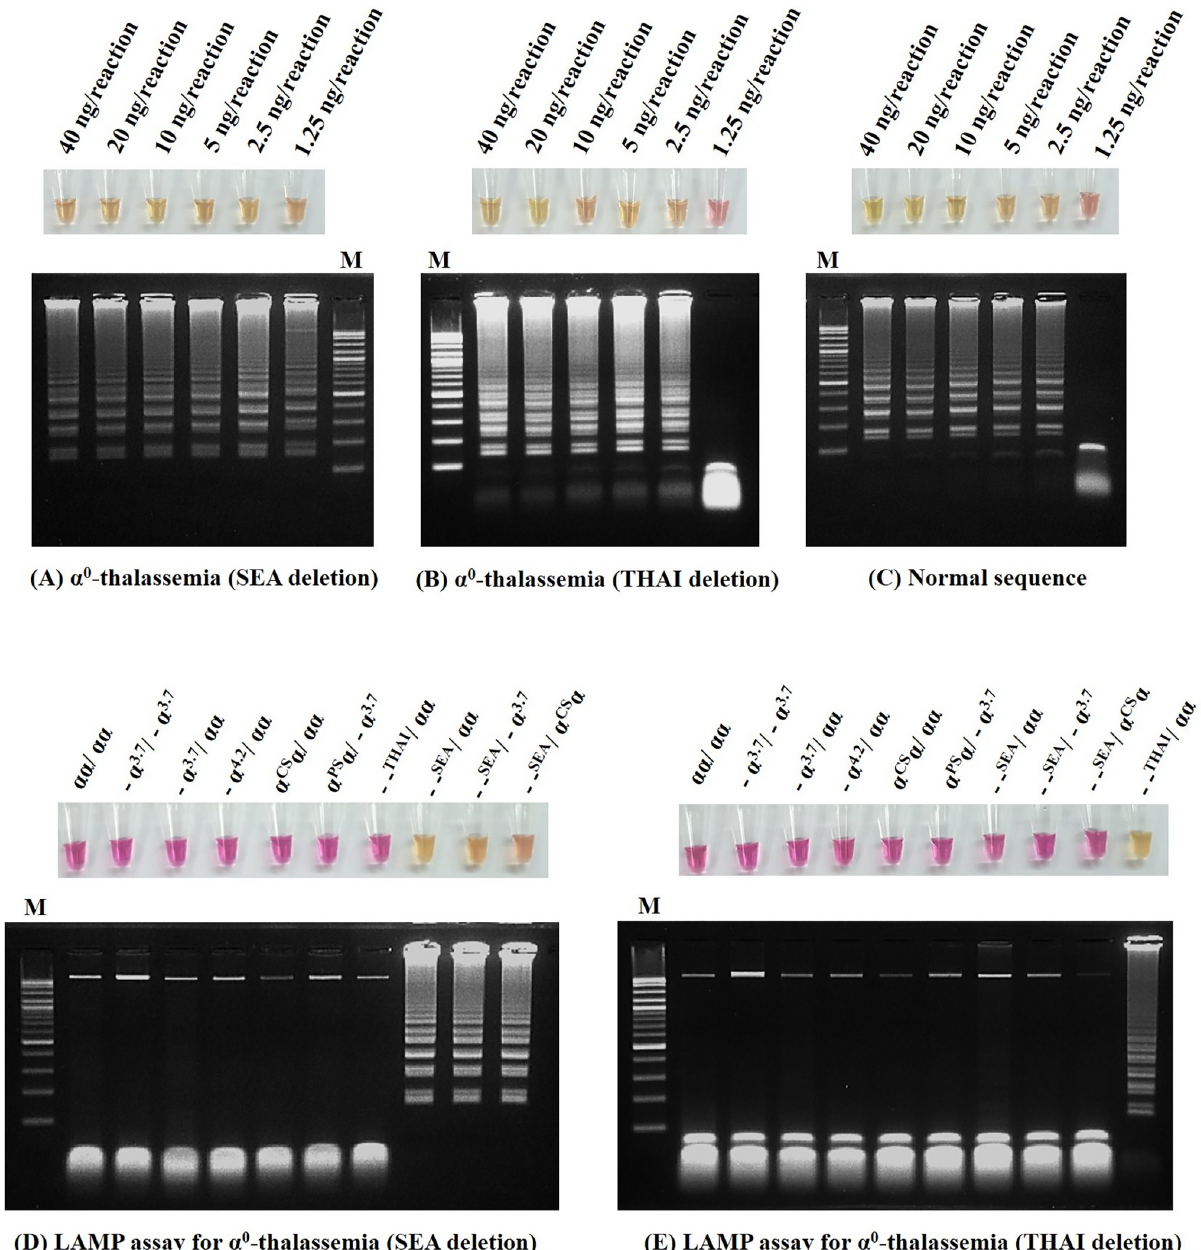
Fig 1. Determination of the lower limit of detection (LOD) of the developed LAMP colorimetric assays for α 0 -thalassemia (SEA and THAI deletion) and gel electrophoresis. The DNA template ranges 1.25–40 ng/reaction, including ( A ) α 0 -thalassemia (SEA deletion), ( B ) α 0 -thalassemia (THAI deletion), and ( C ) normal. Specificity of the developed LAMP colorimetric assays was demonstrated on subjects with various thalassemia genotypes as indicated for ( D ) α 0 -thalassemia (SEA deletion) and ( E ) α 0 -thalassemia (THAI deletion). https://doi.org/10.1371/journal.pone.0267832.g001 (19.6%) subjects tested positive in the LAMP colorimetric assay for α 0 -thalassemia (SEA dele- tion) detection. These included all 62 subjects with α 0 -thalassemia (SEA deletion) and addi- tional positives from five subjects including [ αα / αα , β E / β E ] (n = 2), [- α 3.7 /- α 3.7 , β A / β A ] (n = 1), [- α 3.7 / αα , β A / β A ] (n = 1), and [ αα / αα , β A / β A ] (n = 1). The remaining 274 subjects